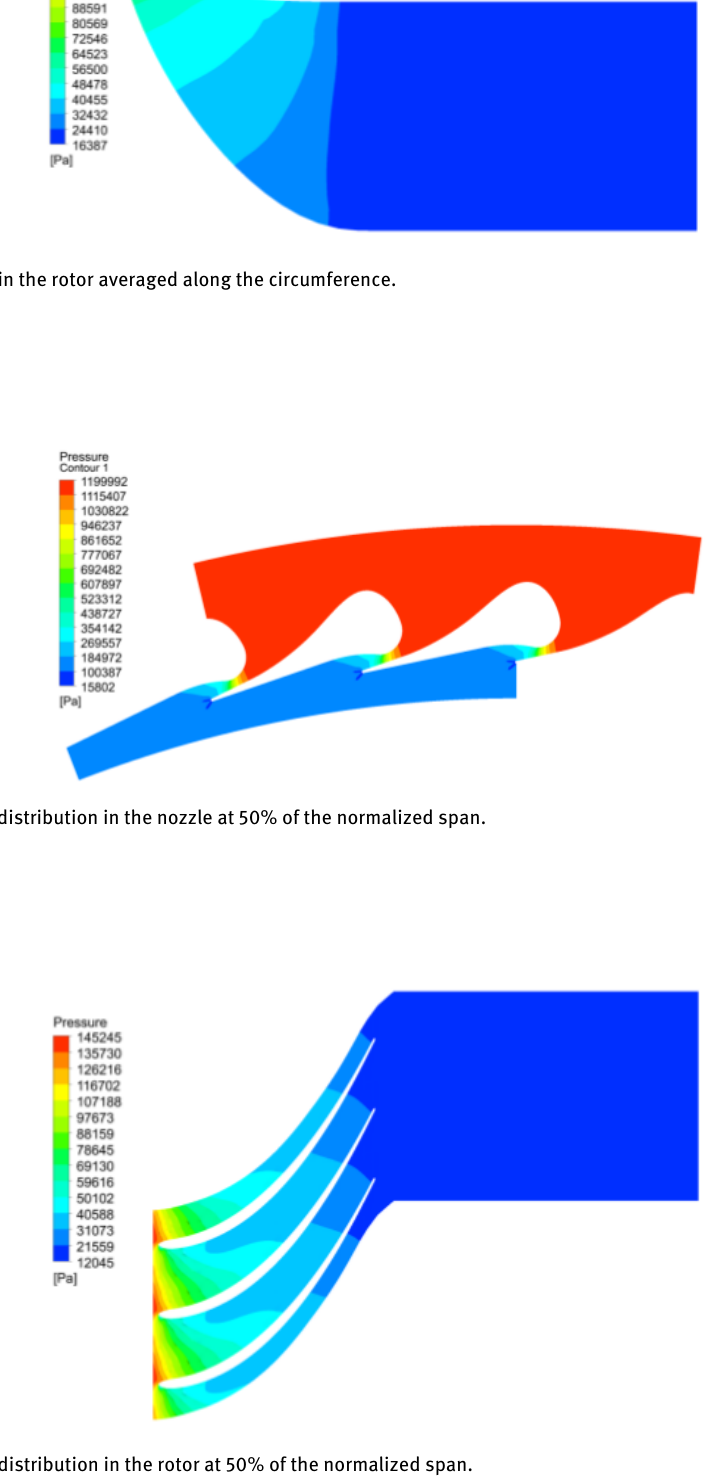
Figure 14: Static pressure distribution in the rotor at 50% of the normalized